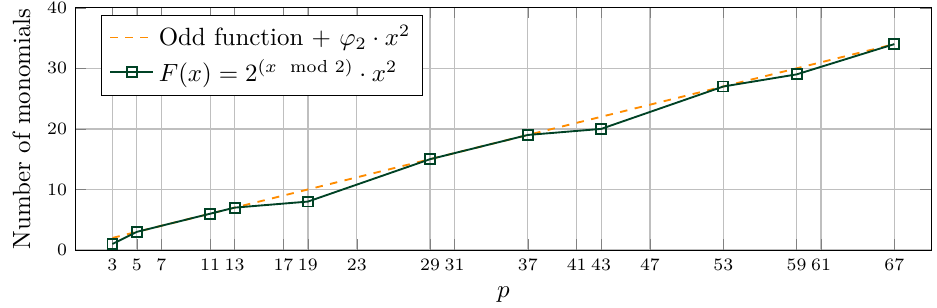
Figure 4: Comparison of the number of monomials for a generic function (with zero constant) and for F ( x ) = 2 ( x mod 2) · x 2 for several values of p .